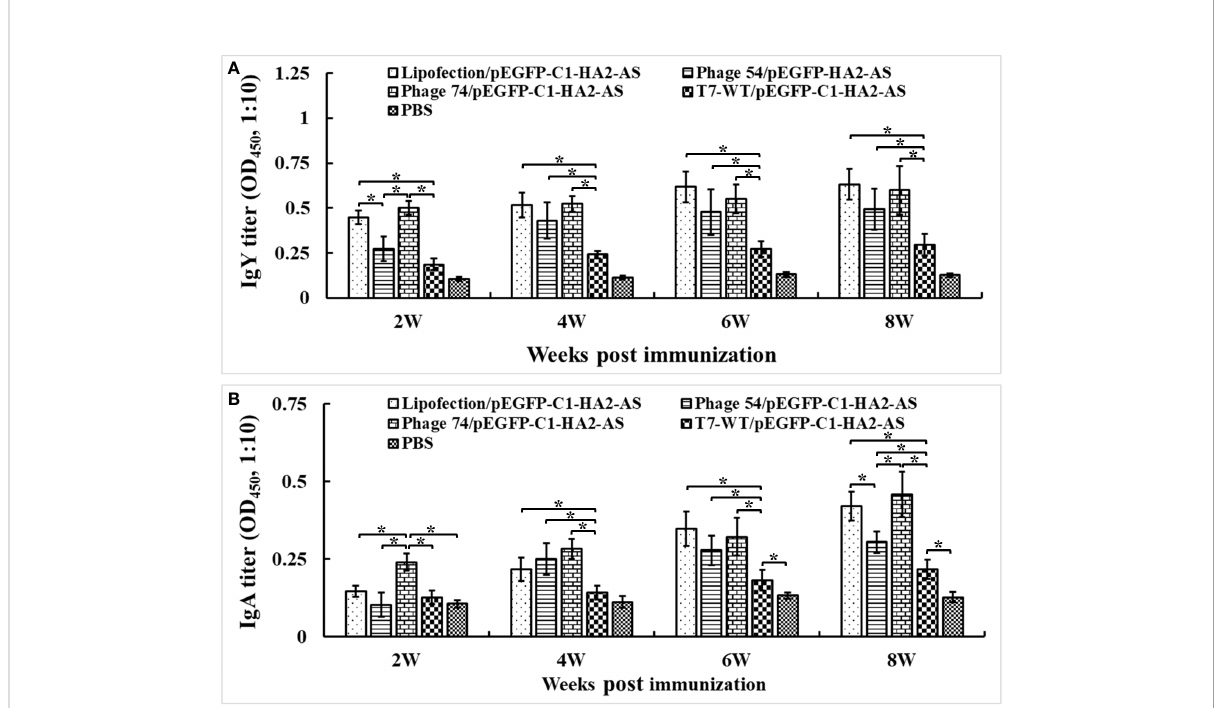
FIGURE 6 Serum IgY and IgA antibodies were detected by ELISA. The speci fi ed pathogen-free (SPF) chickens were immunized twice with Lipofectin and phage particle – delivered DNA vaccine and compared with PBS control at weeks 0 and 4. The serum samples were collected at 2, 4, 6 and 8 weeks post the primary immunization to measure the speci fi c anti-HA2 antibodies. An arti fi cially synthesized truncated HA2 peptide was used to coat the plates, and serum samples were detected with a 10-fold dilution. (A) IgY antibody titers of immunized chickens at each time point. (B) IgA antibody titers of immunized chickens at each time point. Values represent mean ± S.D. (n=10). * p < 0.05 was signi fi cantly